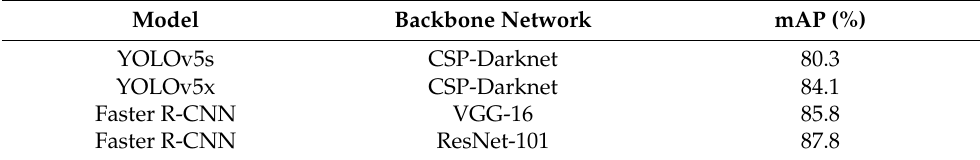
Table 5. Results of the second set of experiments.